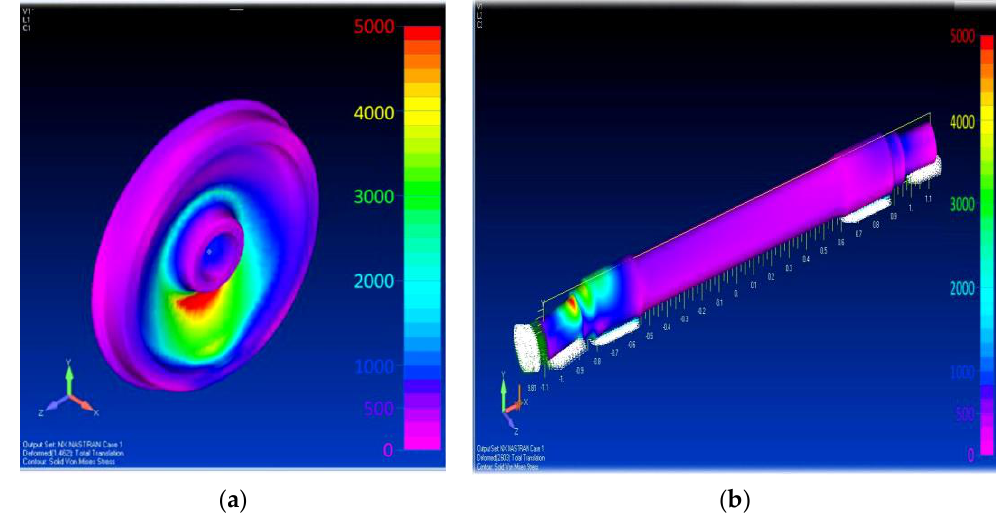
Figure 8. Load distribution across wheel contact elements: ( a ) wheel with critical stresses; ( b ) wheel axis with stresses in the centring plug.